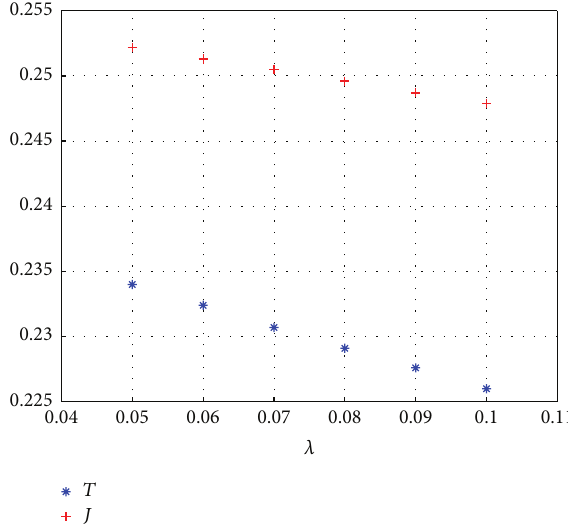
Figure 7: Diagram for transferring payment and social welfare versus shadow cost with